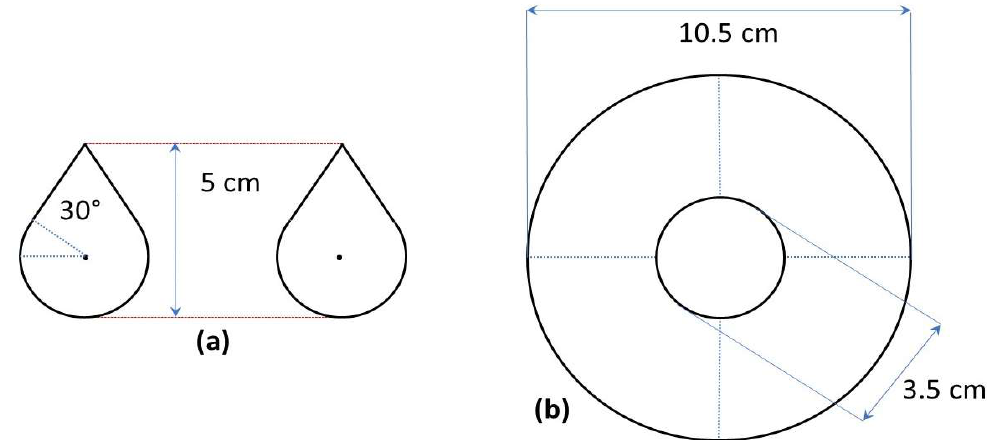
Figure 2. Possible configuration of a ring with asymmetric section (section view ( a ); top view ( b )). The parameterized elements